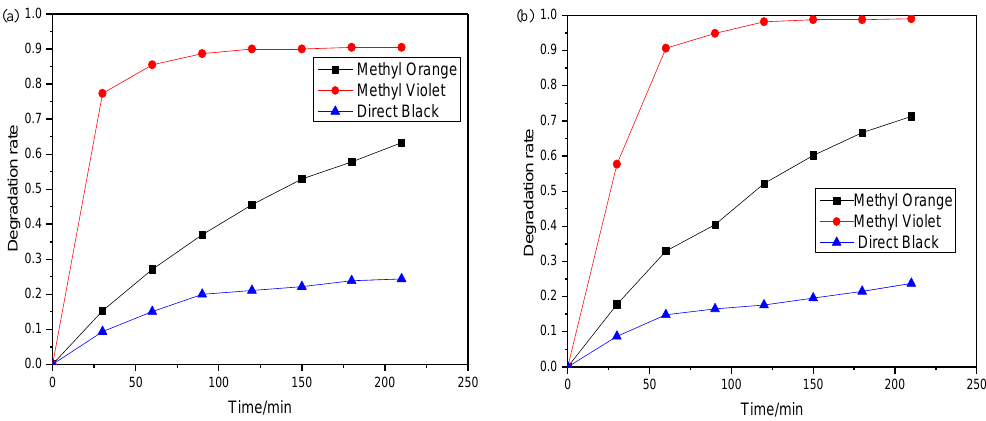
Figure 14. Photocatalytic degradation of typical dyes under natural solar light irradiation with ( a ) BiOI and ( b ) BiOI/BiOCl.